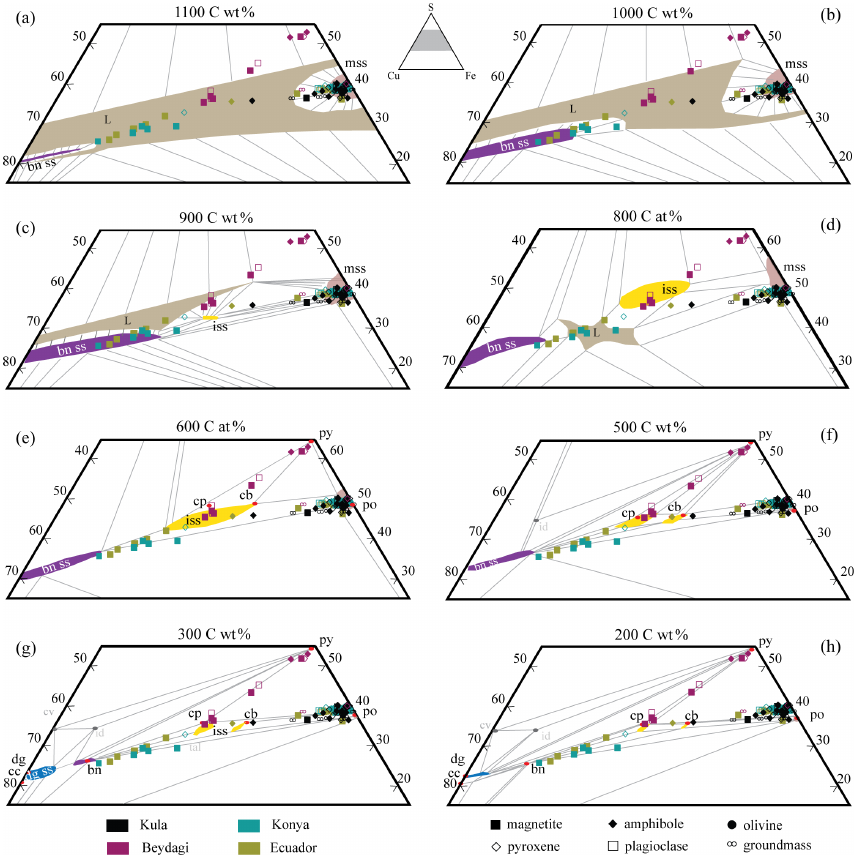
Figure 10. Ternary isothermal sections through the central part of the Cu–Fe–S system according to and modified from (a, b, c) Kullerud et al. (1969), (d) Tsujimura and Kitakaze (2004), (e) Cabri (1973), (f, h) Yund and Kullerud (1966), and (g) Craig and Scott (1974). The stability fields and phase relations at different temperatures are shown for the following: sulfide liquid – L (brown), bornite solid solution – bnss (purple), monosulfide solid solution – mss (pink), intermediate solid solution – iss (yellow), and digenite solid solution – dgss (blue). The data shown correspond to the bulk (area%) reconstructed sulfide compositions hosted by the different phenocrysts and/or groundmass (shape) observed in every study area (colour). For the dataset, see Table 5 at